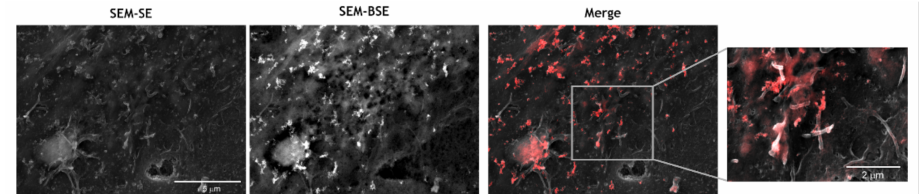
Figure 8. Binding of cerium oxide nanoparticles (CNP) to endothelial microvilli. SEM backscattered electrons images of CNP interaction with membrane protrusions formed by hCMEC/D3 cells after incubation with 1 µ M of A β 1-42 oligomers for 24 h. SEM secondary electrons (SEM-SE) image shows endothelial microvilli. SEM backscattered electrons (SEM-BSE) image shows CNP. The overlay of secondary electrons and backscattered electrons images (merge) and its magnified view (30kx) show the CNP (red) interaction with